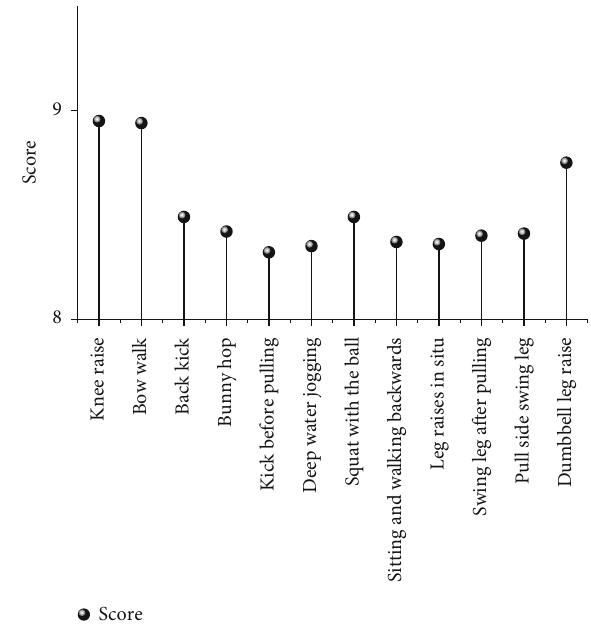
Figure 1: Results of the evaluation of the e ff ectiveness of in-water rehabilitation tools for knee injuries.